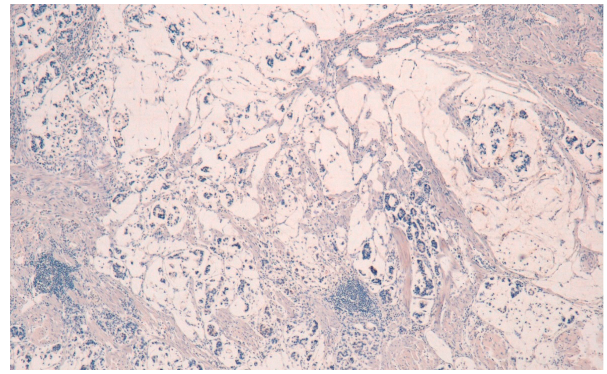
Figure 3. MUC5AC negativity in Pen A ECG (50×).